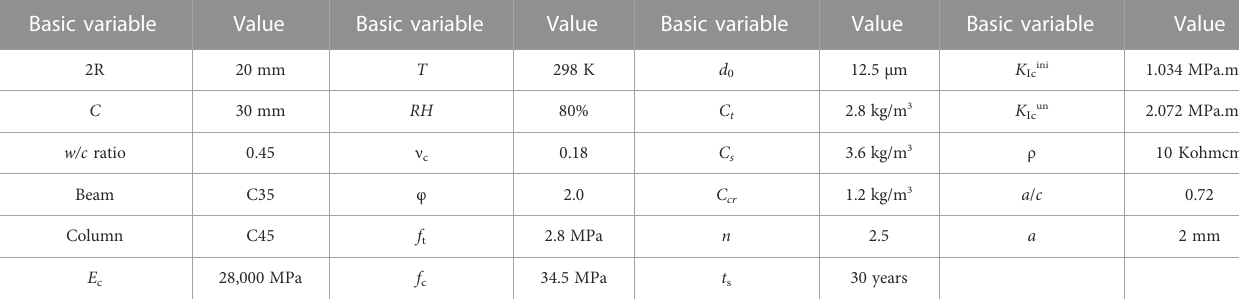
TABLE 5 Field survey data required for model analysis.